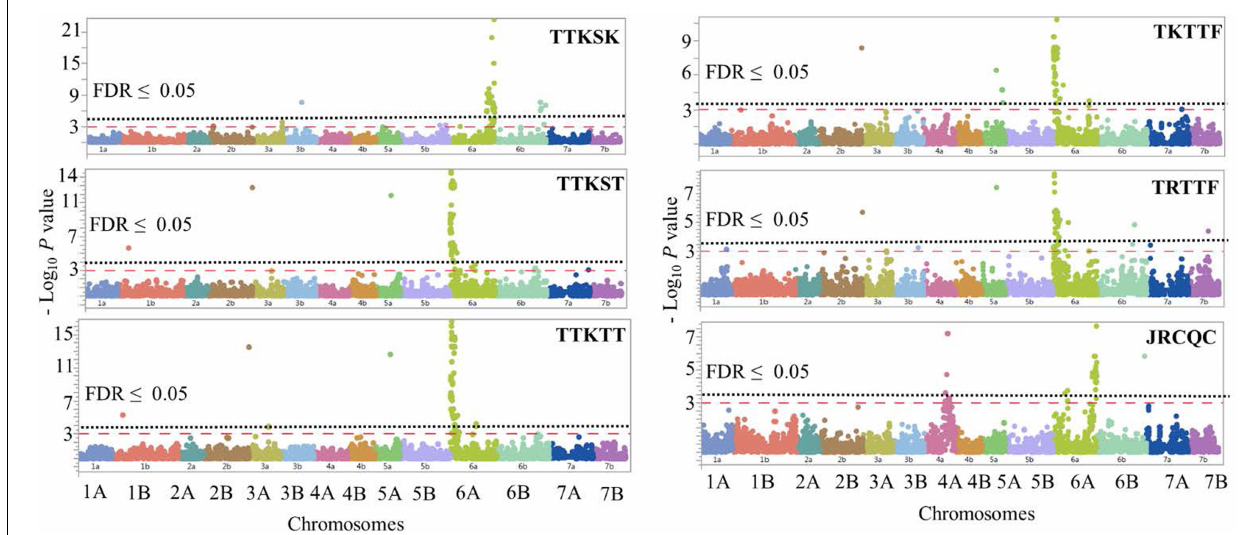
FIGURE 8 | Manhattan plots showing P -values for single-nucleotide polymorphism (SNP) markers associated with response to stem rust in durum wheat genotypes to the three Pgt races TTKSK, TTKST, TTKTT, TKTTF, TRTTF, and JRCQC. The horizontal dashed red line indicates significance level at P -value ≤ 0.001. The horizontal dotted black line indicates significance level at FDR ≤